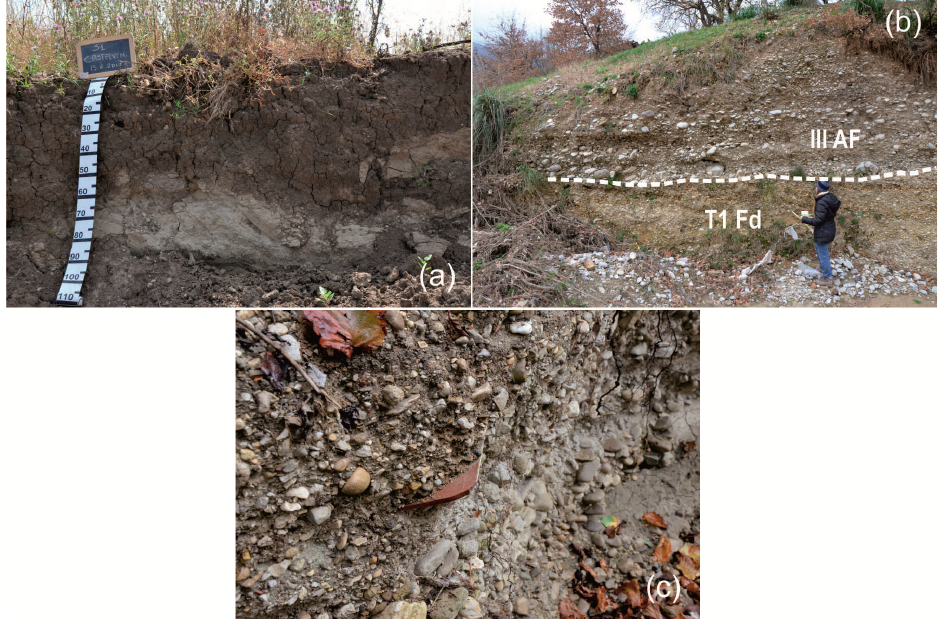
Figure 8. ( a ) NYT reworked tephra layer in the colluvial deposits covering the T1 terrace; ( b ) erosional contact (white dotted line) between the deposits of the third AF generation (III AF) and the fluvial deposits of T1 (T1 Fd); ( c ) heterometric, sub-angular to sub-rounded pebbles of the 3rd AF generation containing recent anthropic artifacts.